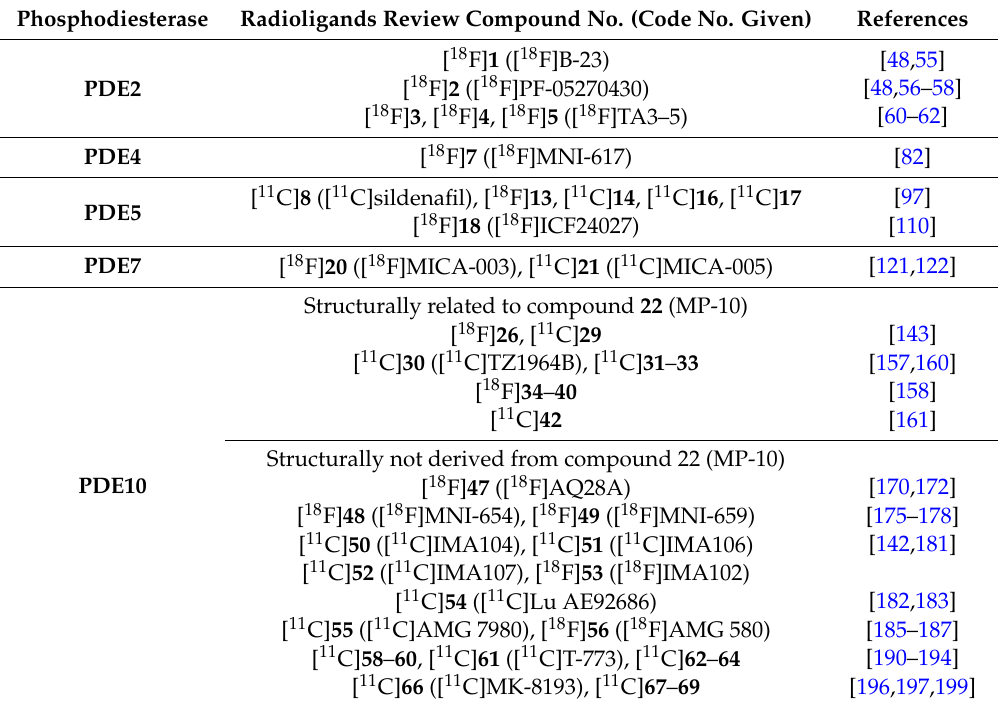
Table 1. Update of novel radioligands for PET imaging of PDEs 2, 4, 5, 7, and 10 since 2012. Phosphodiesterase Radioligands Review Compound No. (Code No.